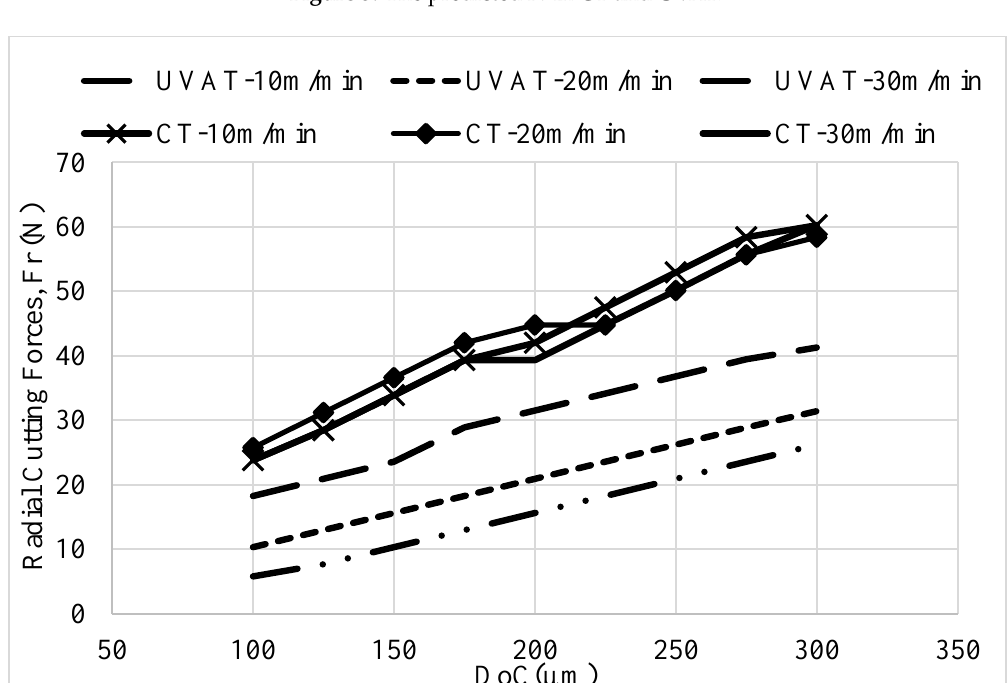
Figure 6. The predicted Fr in CT and UVAT.